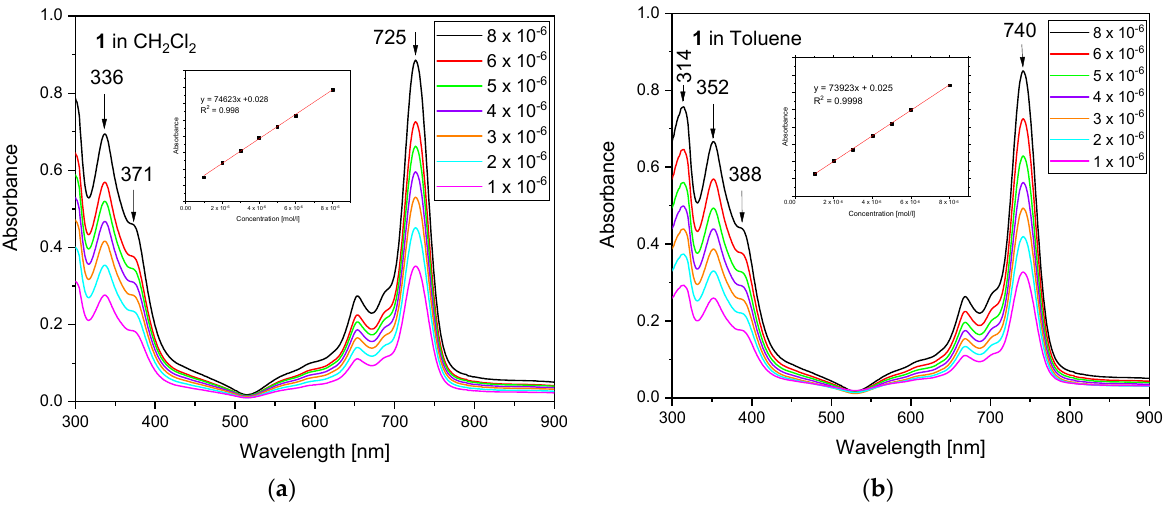
Figure 7. Optical absorption spectra of SbPc-complex 1 in CH 2 Cl 2 ( a ) and in toluene ( b ) at various concentrations (8 × 10 − 6 –1 × 10 − 6 mol/L).